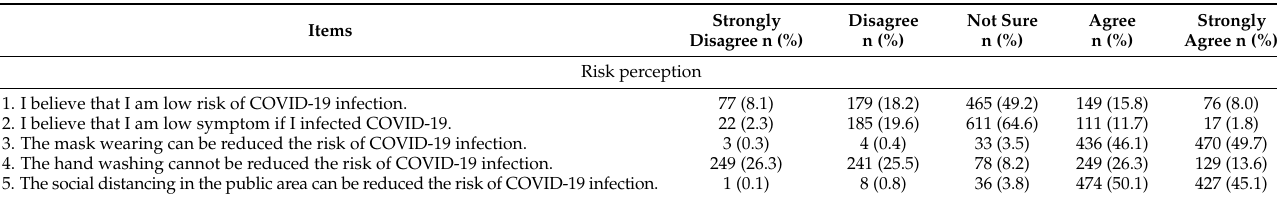
Table 4. Attitude towards